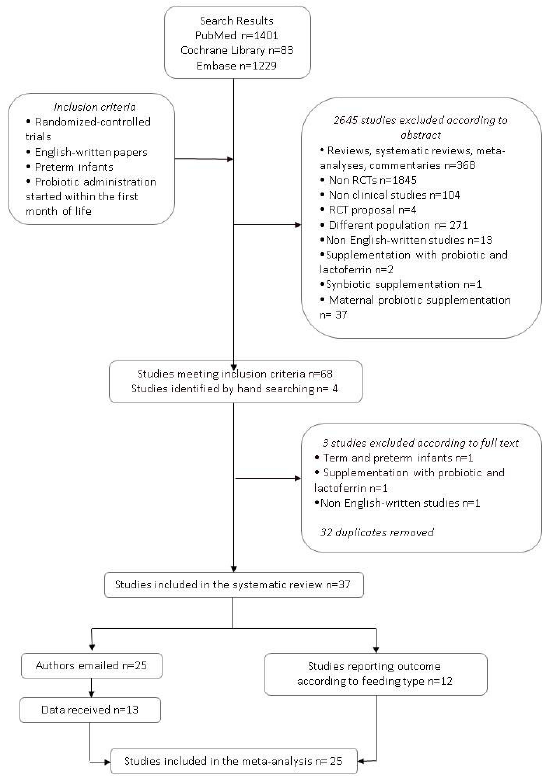
Figure 1. Flow chart of the search strategy and search results. The relevant number of papers at each point is given.